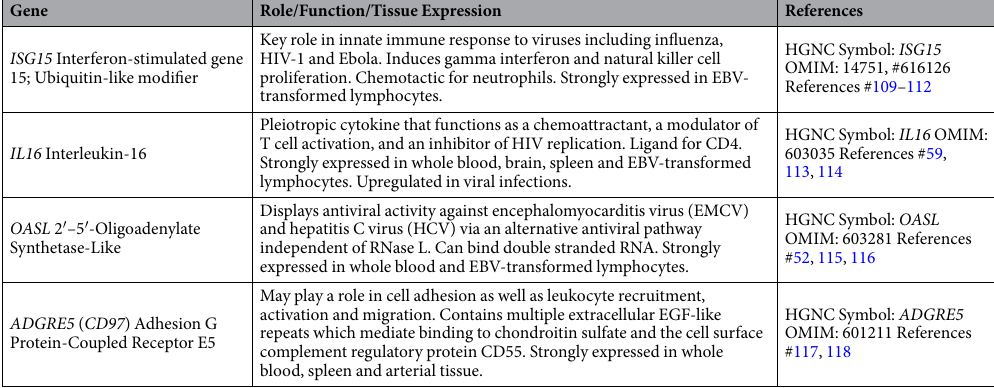
power of the signature. Figure 1B shows box and whisker plots for ISG15/IL16 performance on weekly whole blood samples out to 29 days post-inoculation in piglets infected with PCV2. The ISG15/IL16 component of the pan-viral signature produced AUC = 0.94 for day 7 vs. day 0 comparison, and AUC = 1.00 for days 14, 21, 29 vs. day 0 comparison.